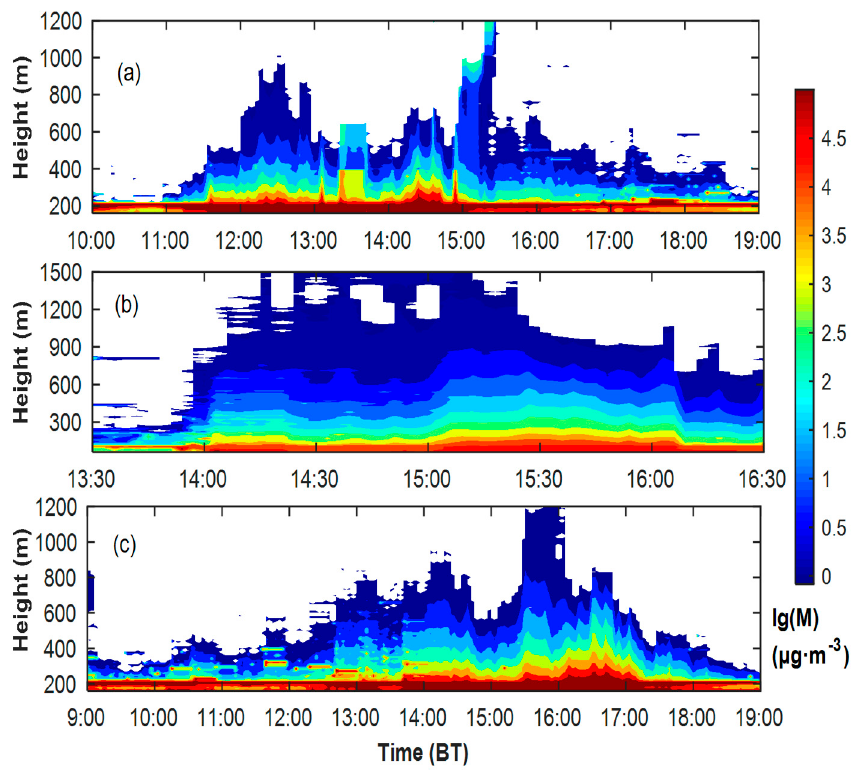
Figure 9. The temporal and altitudinal distributions of dust mass concentrations on ( a ) 7 May, ( b ) 20 May and ( c ) 24 May.